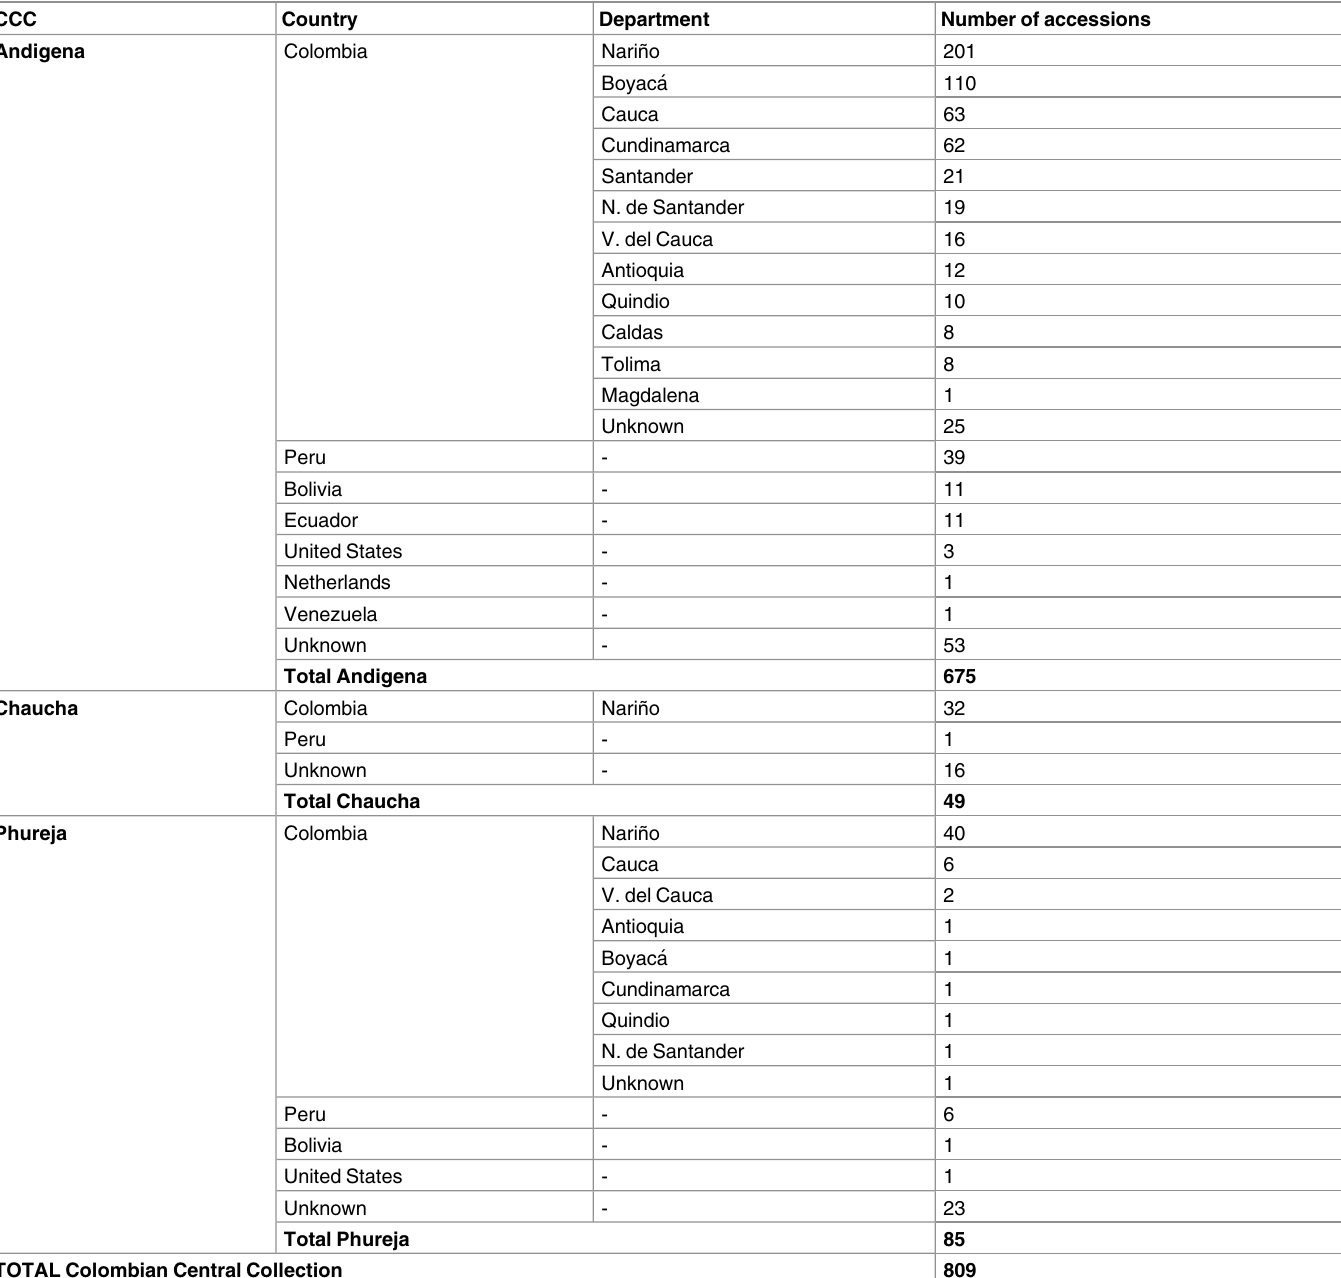
Table 1. Summaryof the 809 accessions of the Colombian Central Collection of S . tuberosum Andigenum group used in this study. CCC